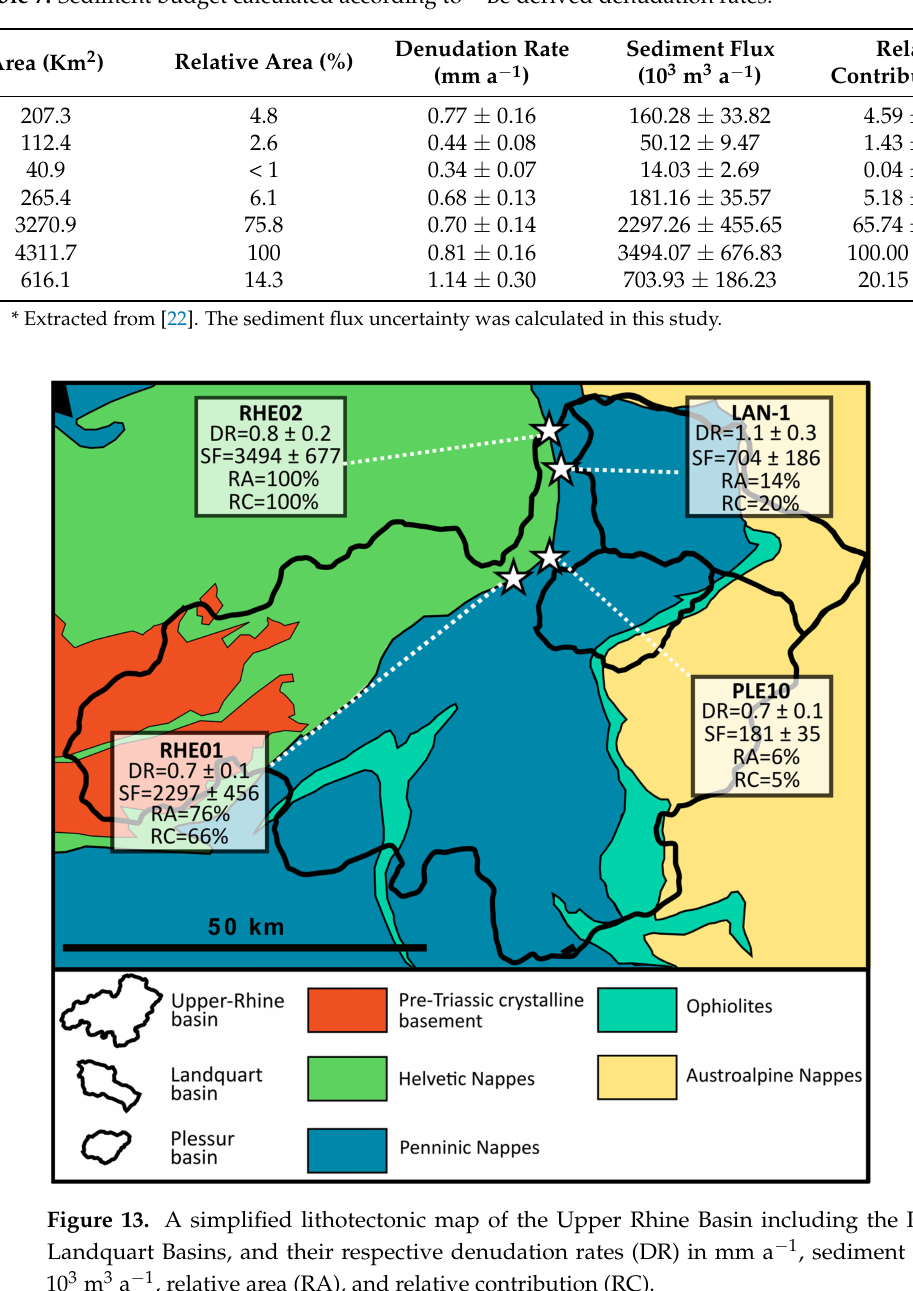
Table 7. Sediment budget calculated according to 10 Be derived denudation rates.